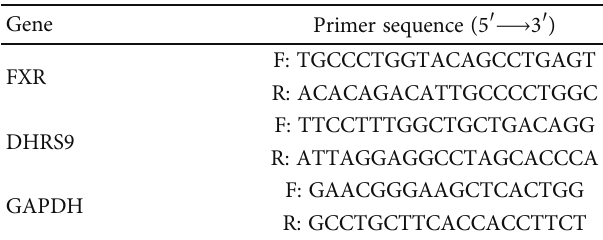
Table 1: qRT-PCR primer sequence. Gene Primer sequence (5 ′ ⟶ 3 ′